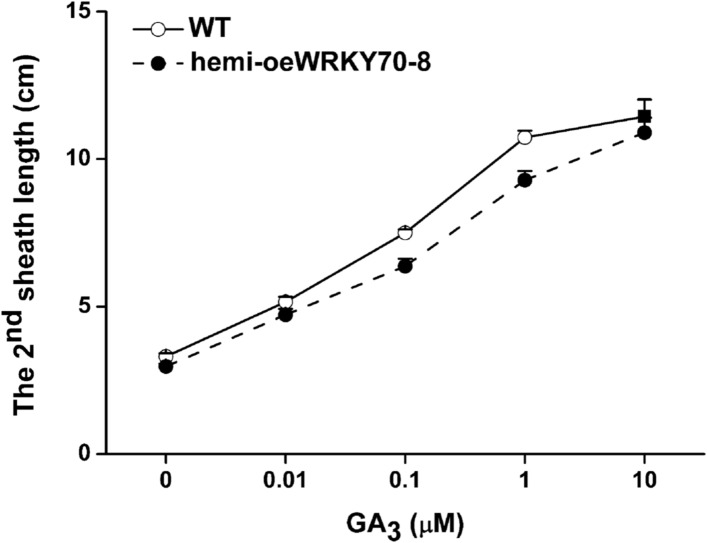
Elongation of the second leaf sheath in hemi-oeWRKY70-8 and WT plants in response to GA3.WT and hemi-oeWRKY70-8 seeds were surface sterilized and placed on 1/2 Murashige and Skoog agar medium containing GA3 (minimum purity > 99%, Sigma) at various concentrations. The length of the second leaf sheaths was measured 10 days later.